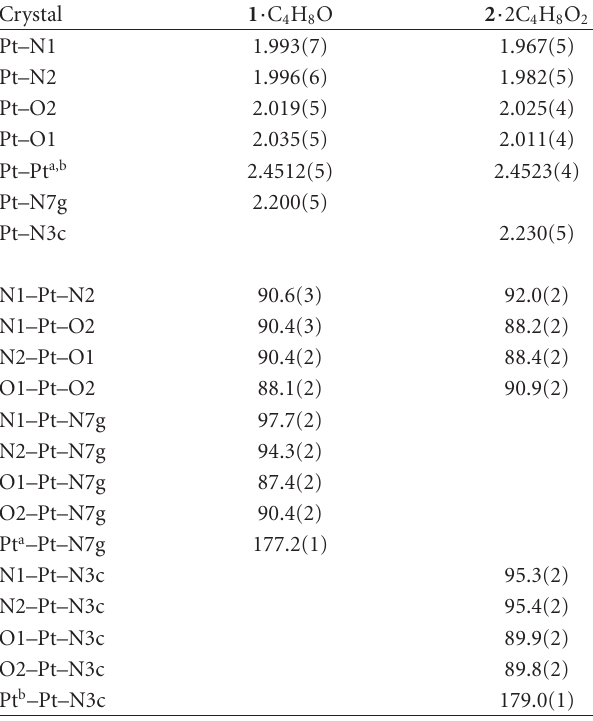
Table 2: Bond lengths [ ˚A] and angles [ ◦ ] for [Pt 2 { HN = C(Bu t )O } 4 · (9-EtG) 2 ](NO 3 ) 2 · tetrahydrofurane ( 1 · C 4 H 8 O) and [Pt 2 { HN = C(